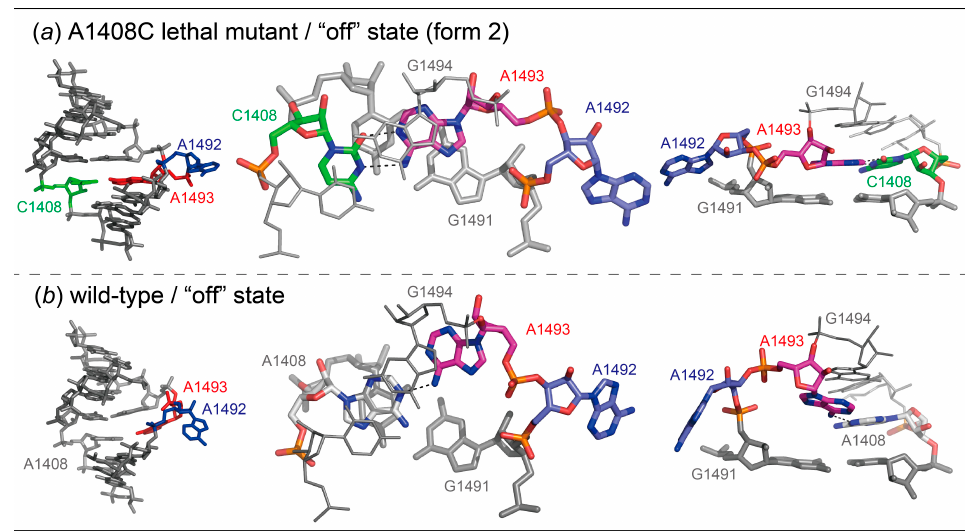
Figure 4. Molecular structures (left) and close-up views of base pairs (center) and stacking interactions (right) observed in the “off” state form 2 of the bacterial A1408C lethal mutant ( a ) and wild type (28: PDB-ID = 3BNL) ( b ) A sites.